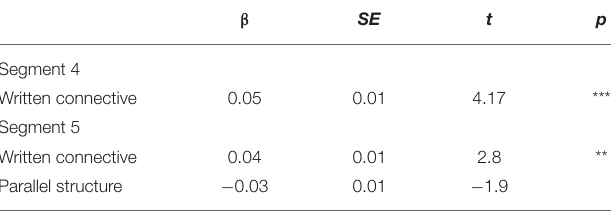
TABLE 5 | Model of the L1 data on segments 4 and 5 (Experiment 2).